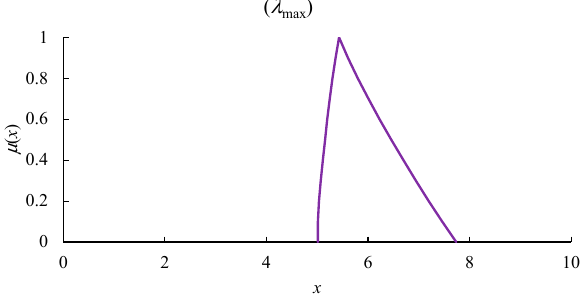
Figure 7. Values of fuzzy maximal eigenvalue derived using ACO.